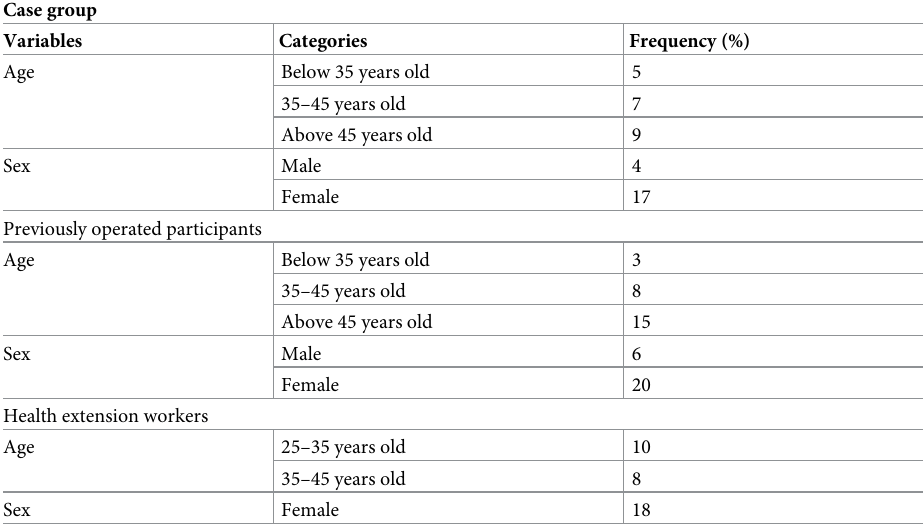
Table 1. Socio-demographic characteristics of focus group